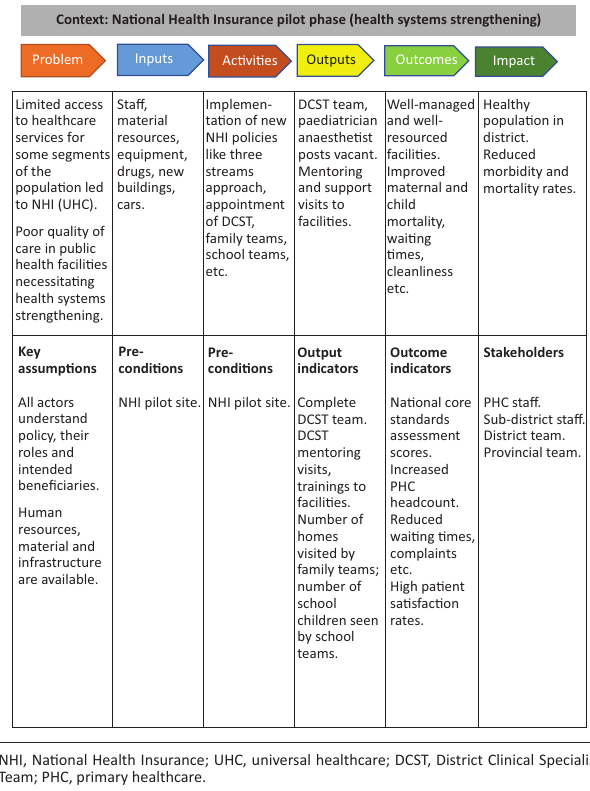
FIGURE 1: Theory of change for the National Health Insurance pilot